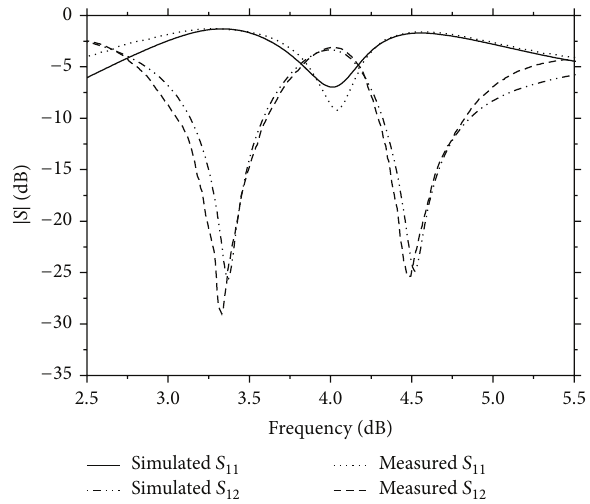
Figure 5: The 𝑆 -parameters of the filter with optimized dimensions.